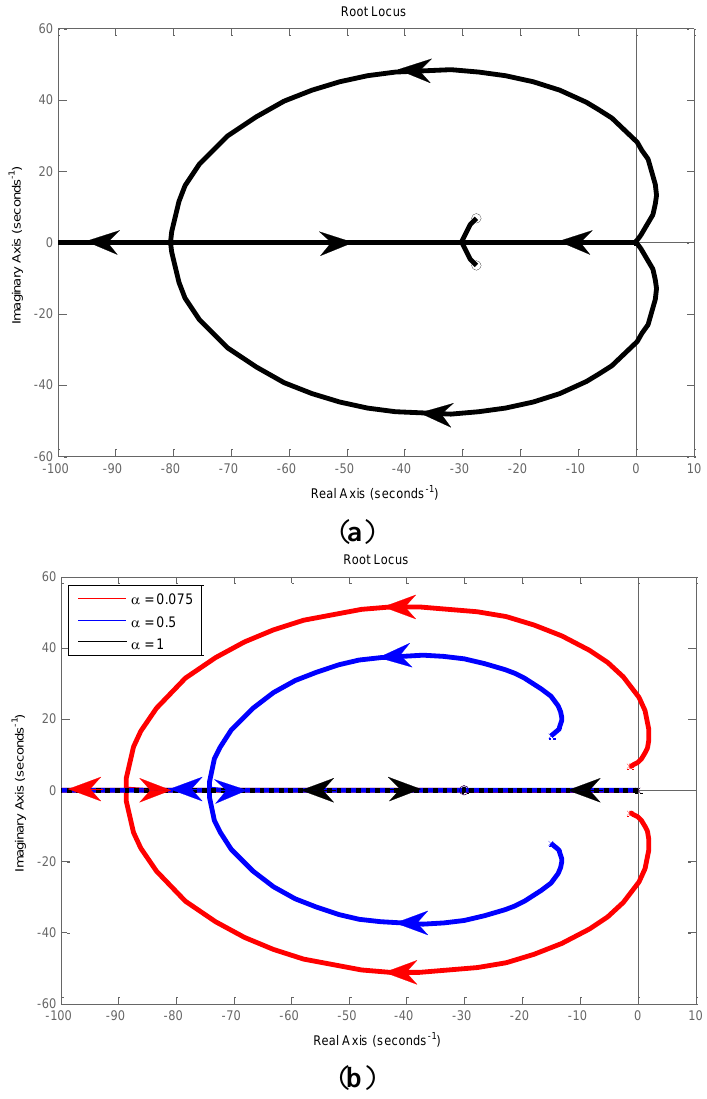
Figure 5. Root locus of the robust position control system. ( a ) Root locus with respect to α; ( b ) Root locus with respect to R when α has different